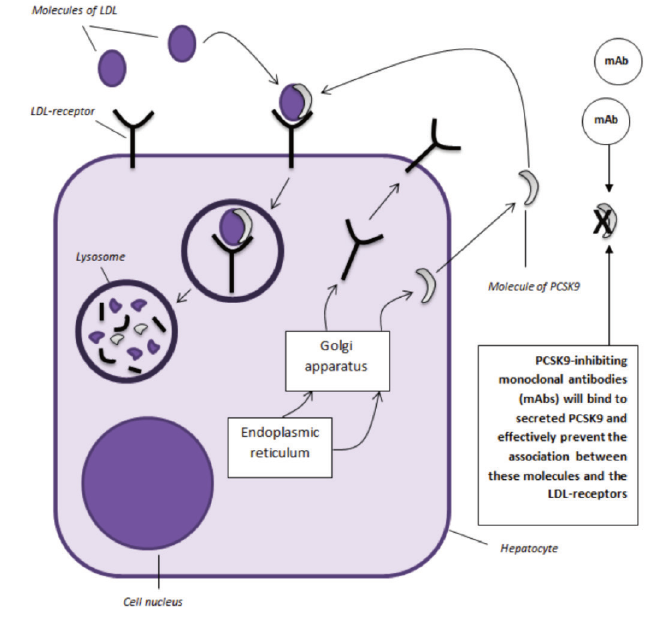
Figure 2: A simplified diagram of a prototypical hepatocyte, illustrating the production and release of proprotein convertase subtilisin/kexin type 9, with its subsequent role in the degradation of the low-density lipoprotein receptor, and showing the site of action of the proprotein convertase subtilisin/kexin type 9-inhibiting monoclonal antibodies